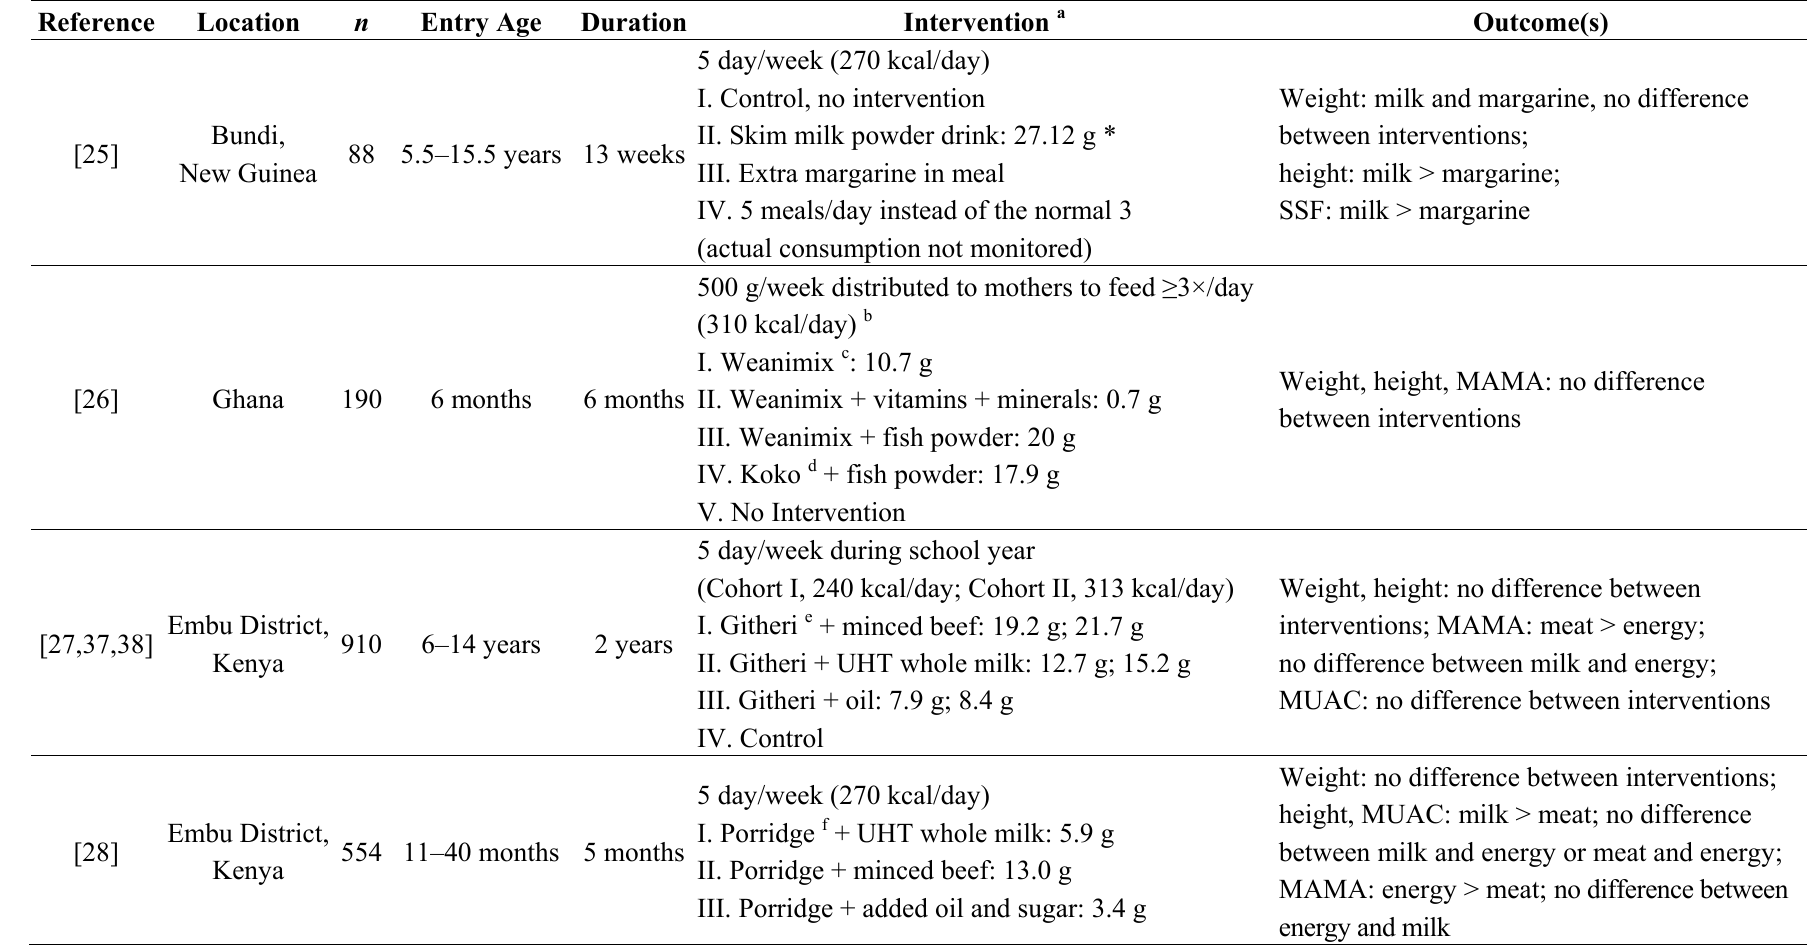
Table 3. Growth effects from isocaloric animal source food (ASF) vs. non-ASF